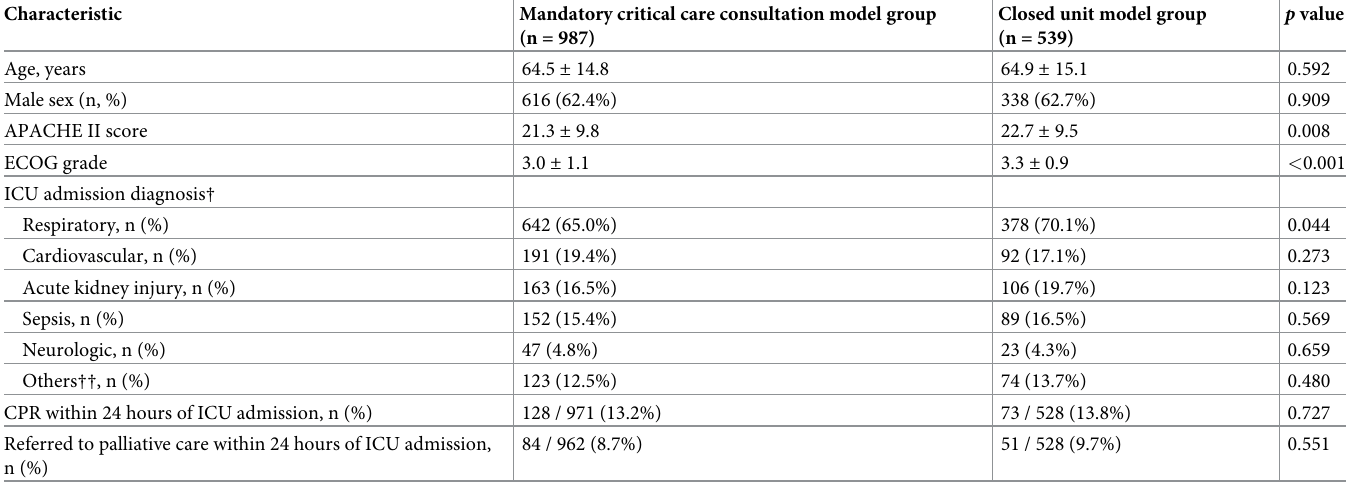
Table 1. Baseline characteristics of the